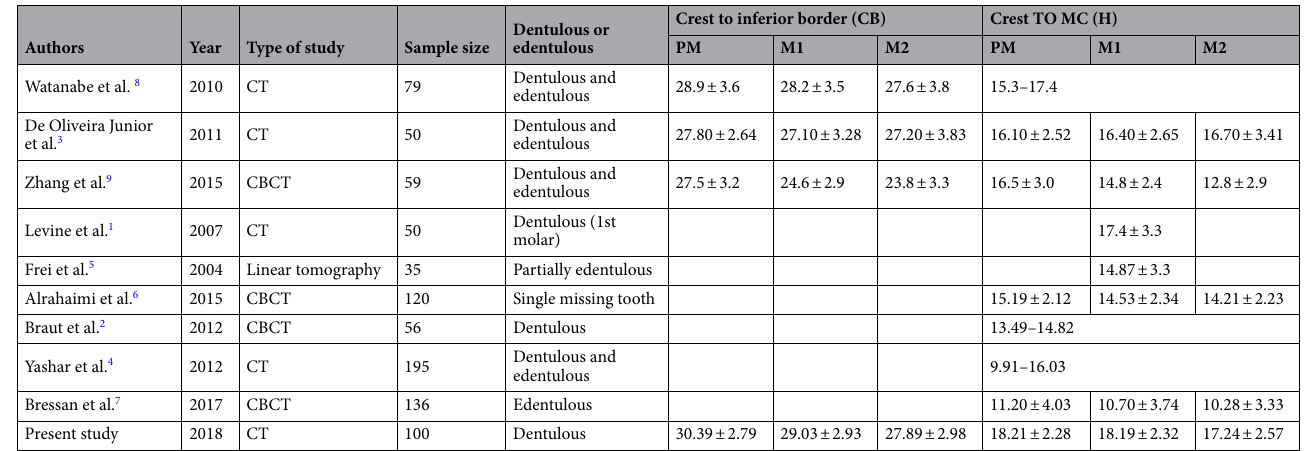
Table 8. Comparison of bone height (BH) values in the